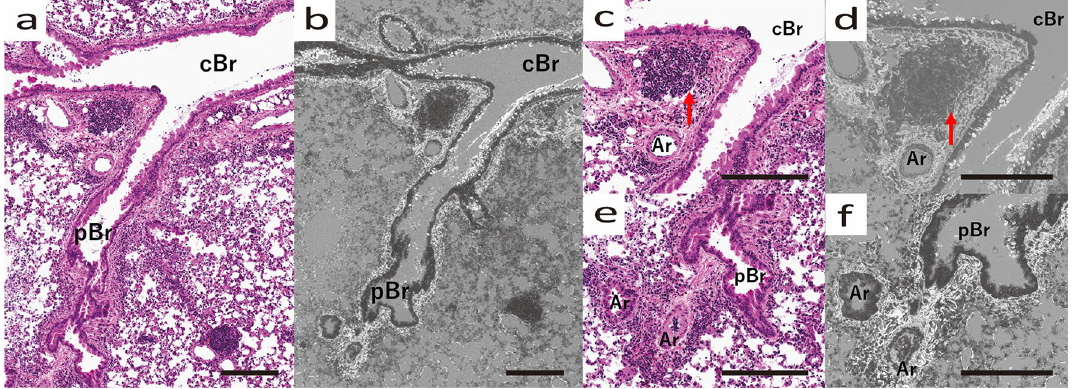
Figure 4. Morphological changes of central to peripheral bronchi in HDM-sensitized B6 mouse. ( a ) Optical microscope image (HE stained) and ( b ) SEM image (Grocott stained) of the bronchi. Central bronchus (cBr) and peripheral bronchus (pBr) are shown. ( c ) Optical microscope image (HE stained) and ( d ) SEM image (Grocott stained) of cBr and Ar, Lymph node (arrow) between cBr and Ar is seen. ( e ) Optical microscope image (HE stained) and ( f ) SEM image (Grocott stained) of pBR and Ar. ( a , b ) Mucus production was higher in the central part and lower in the peripheral part. ( c , d ) Lymph nodes are enlarged in the amorphous matrix between the extravascular lumen and bronchi. All scale bars show 200 μm